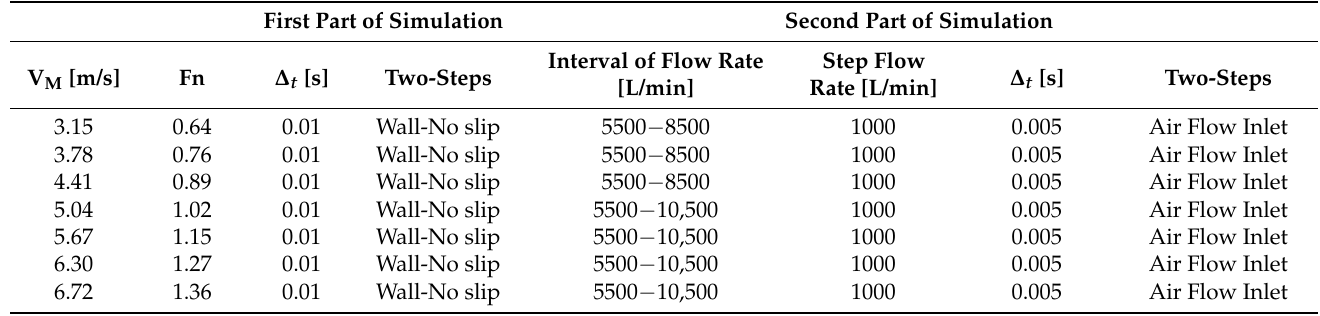
Table 4. Velocities and time-step used for the